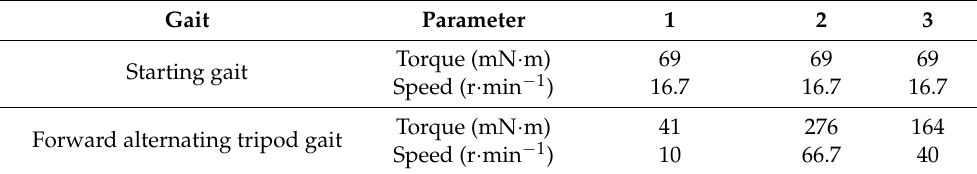
Table 1. List of theoretical motor parameters.